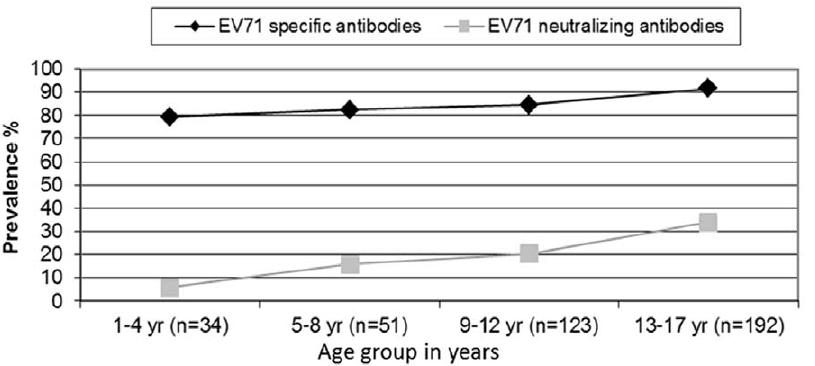
Figure 6. Prevalence (%) of EV71-specific and neutralizing antibody by age group. The prevalence of EV71- specific and neutralizing antibody was evaluated among four age groups. The prevalence of EV71-specific antibody was determined based on the percentage of samples which were positive in EB-ELISA. The prevalence of EV71 neutralizing antibody was determined based on the percentage of samples which were positive in virus neutralization. n: number of samples in each age group.